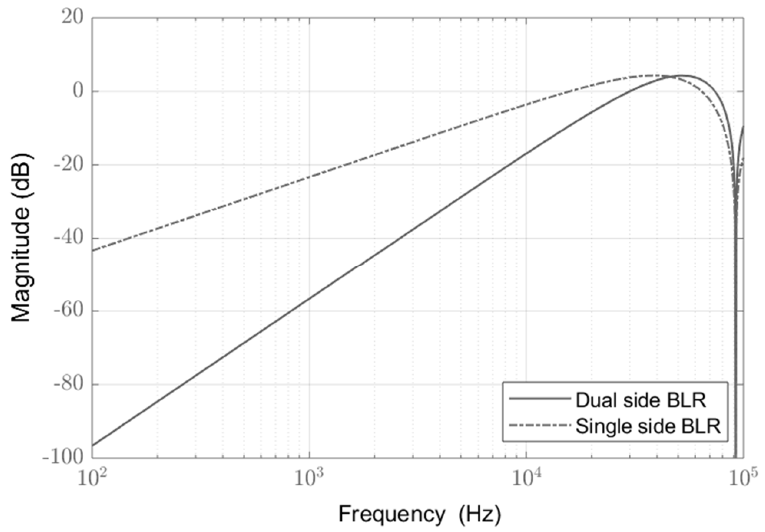
Figure 5. Frequency response for the single-side and the proposed double-side digital baseline restorer.